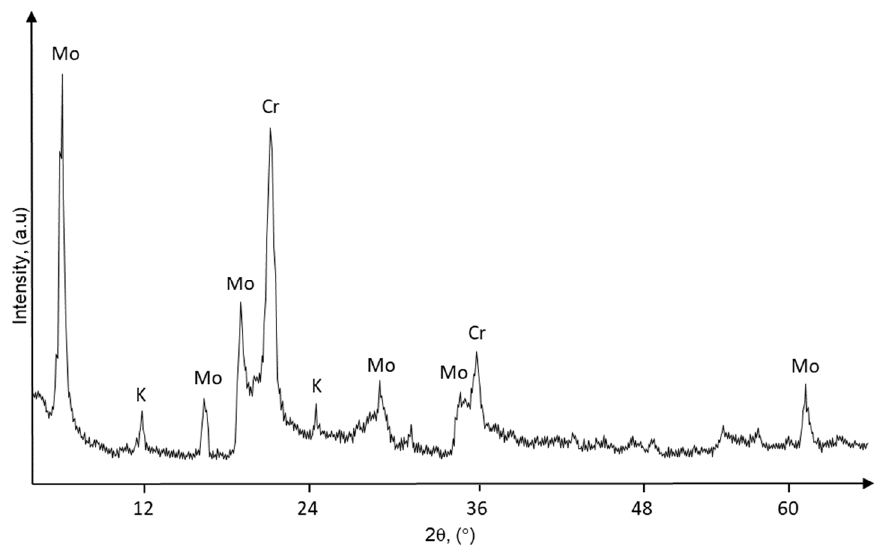
Figure 9. XRD of a bentonite sample containing montmorillonite and cristobalite with small amounts of kaolinite (Mo—Montmorillonite; Cr—Cristobalite; K—kaolinite).